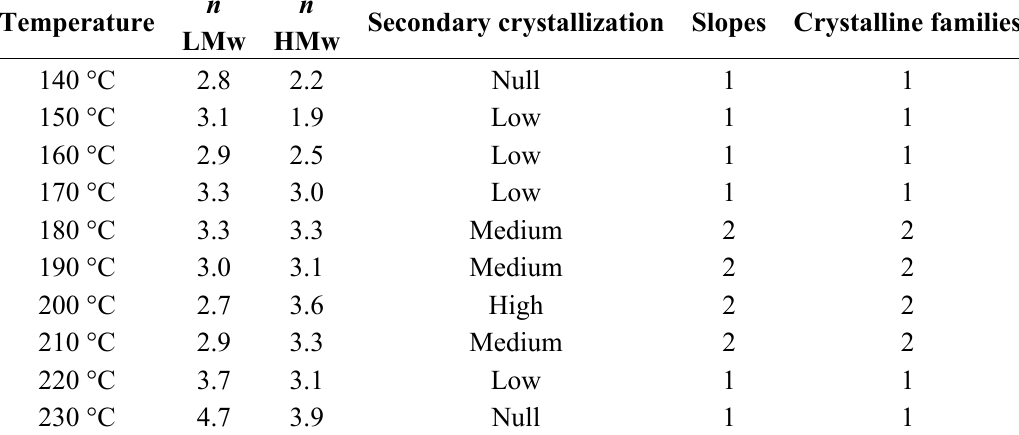
Table 1. Morphological parameters from Avrami analysis of isothermally crystallized PET samples at different